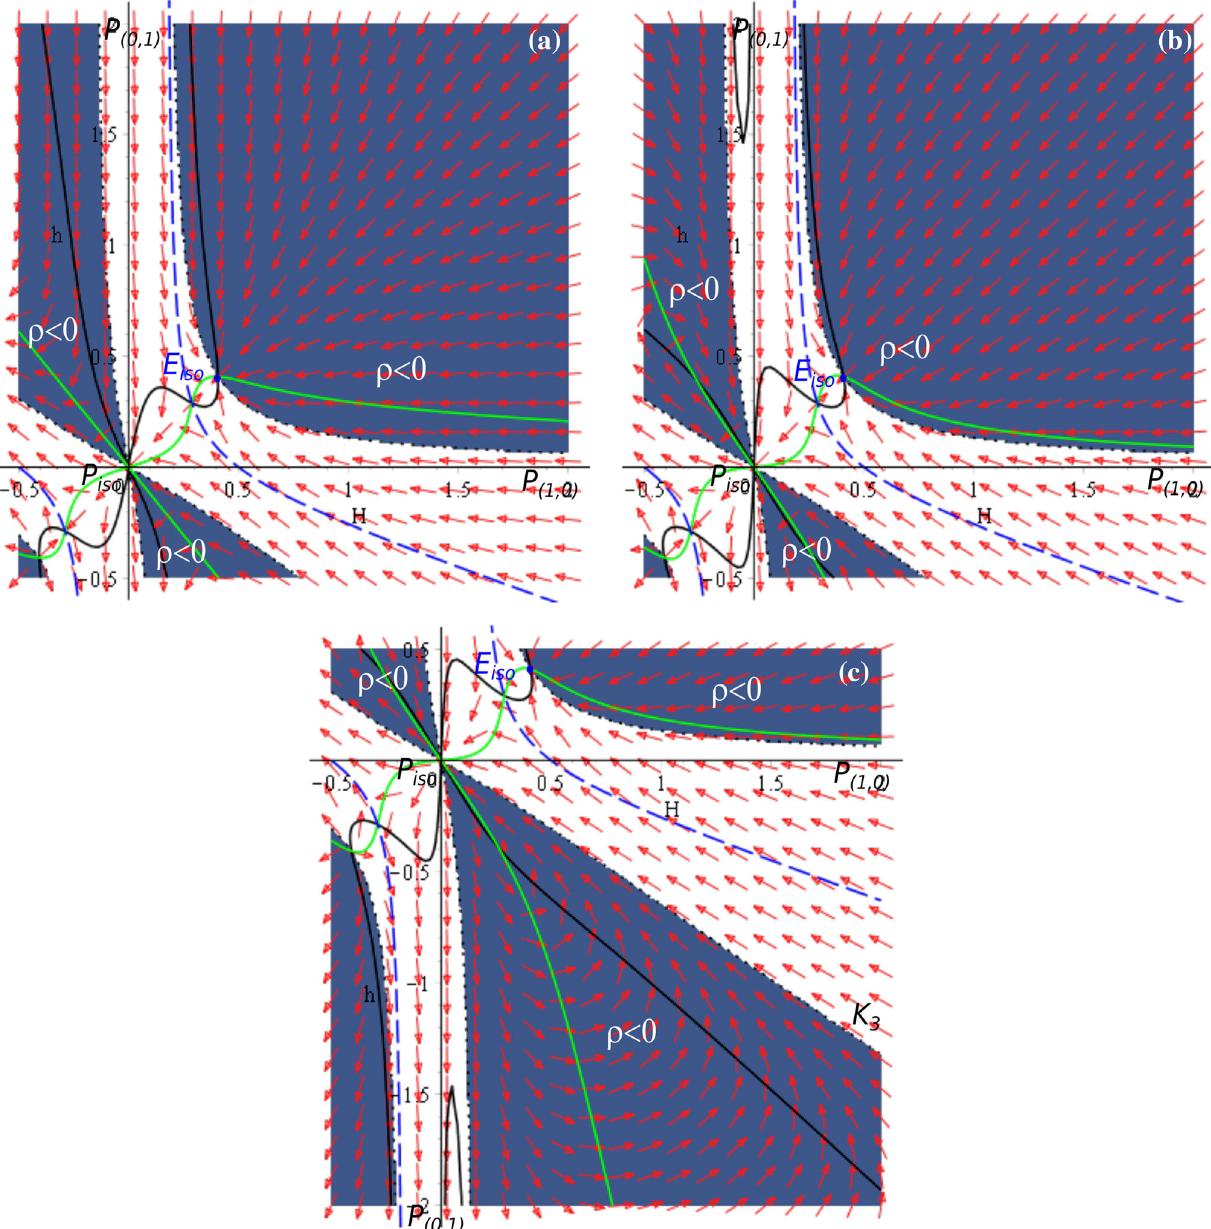
Fig. 9 Phase portraits for D = 2 α < 0, ω > 0 case: focus on h > 0 regimes for 1 / 3 > ω > 0 on a , focus on h > 0 regimes for ω > 1 / 3 on b and focus on h < 0 regimes for ω > 1 / 3 on c . Dashed blue